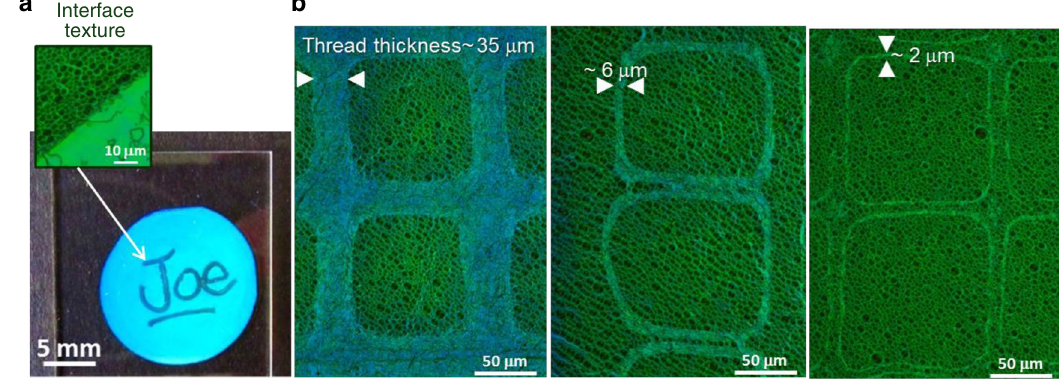
Fig. 4 Practical uses in visual cryptography. Multiscale optical tags with taggants from the a millimetre to b